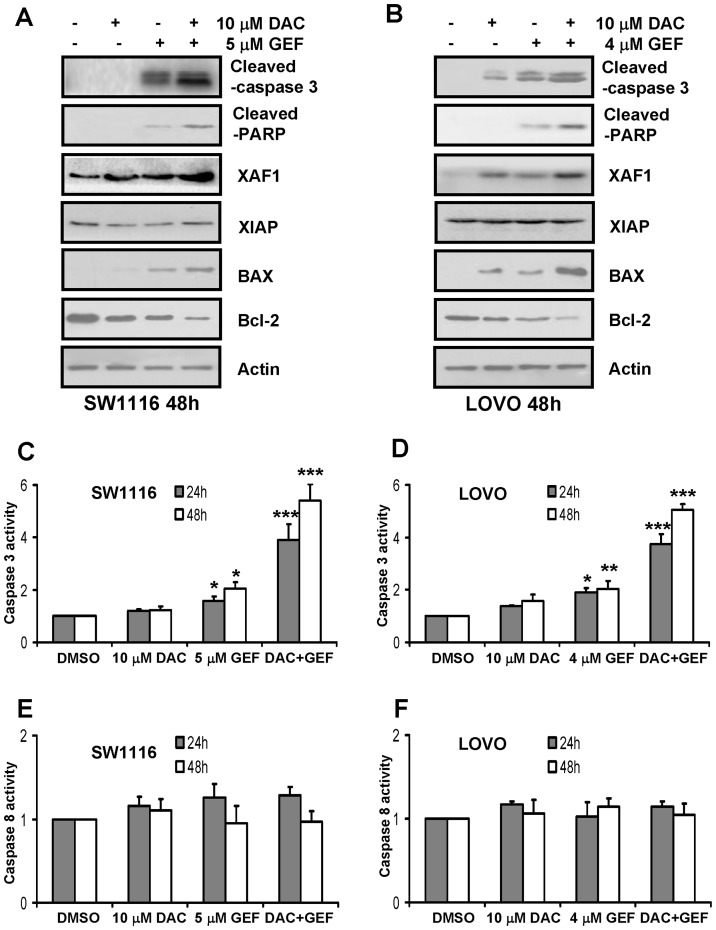
Decitabine and gefitinib combination therapy alters the expression levels of apoptotic regulatory factors.SW1116 and LOVO cells were plated, treated for 48(DAC) and gefitinib (GEF) either alone or in combination. (A) and (B) the expression levels of cleaved-caspase 3, cleaved-PARP, XAF1, XIAP, BAX, Bcl-2 were determined by Western blot analysis as described under Methods. Expression of β-actin served as a loading control. The data are representative of three independent experiments. (C) and (D) The caspase 3 activity was quantified as described under methods. This experiment was repeated thrice. Columns, mean; bars, SD. *, P<0.05; **, P<0.01; ***, P<0.001. (E) and (F) The caspase 8 activity was quantified as described under Methods. This experiment was repeated thrice. Columns, mean; bars, SD. *, P<0.05; **, P<0.01; ***, P<0.001.